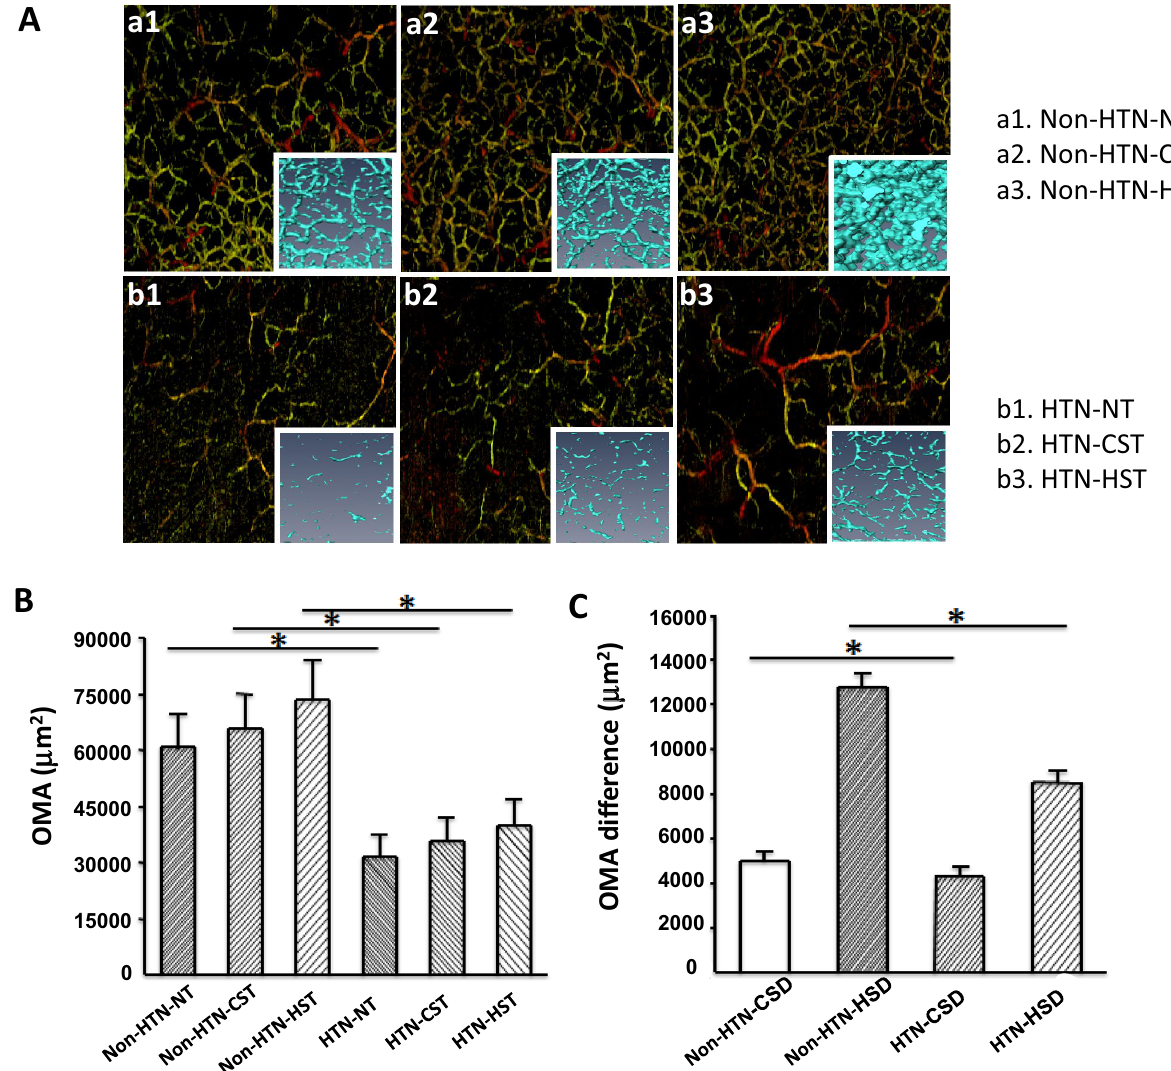
Figure 2. ( A ) Microvascular network imaging under the back of the hand, three-dimensional blood vessel model imaging, a1 normal skin temperature test (NT), a2 cold stimulation test (CST), a3 warm stimulation test (HST), b1 HTN in NT, b2 HTN in CST, b3 HTN in HST; ( B ) histogram of variance of blood vessel area; ( C ) histogram of variance of blood vessel area; non-HTN n = 54, HTN n = 36, * indicates that the comparison between NT, CST, HST, CSD, HSD in non-HTN vs. NT, CST, HST, CSD, HSD in HTN, p <